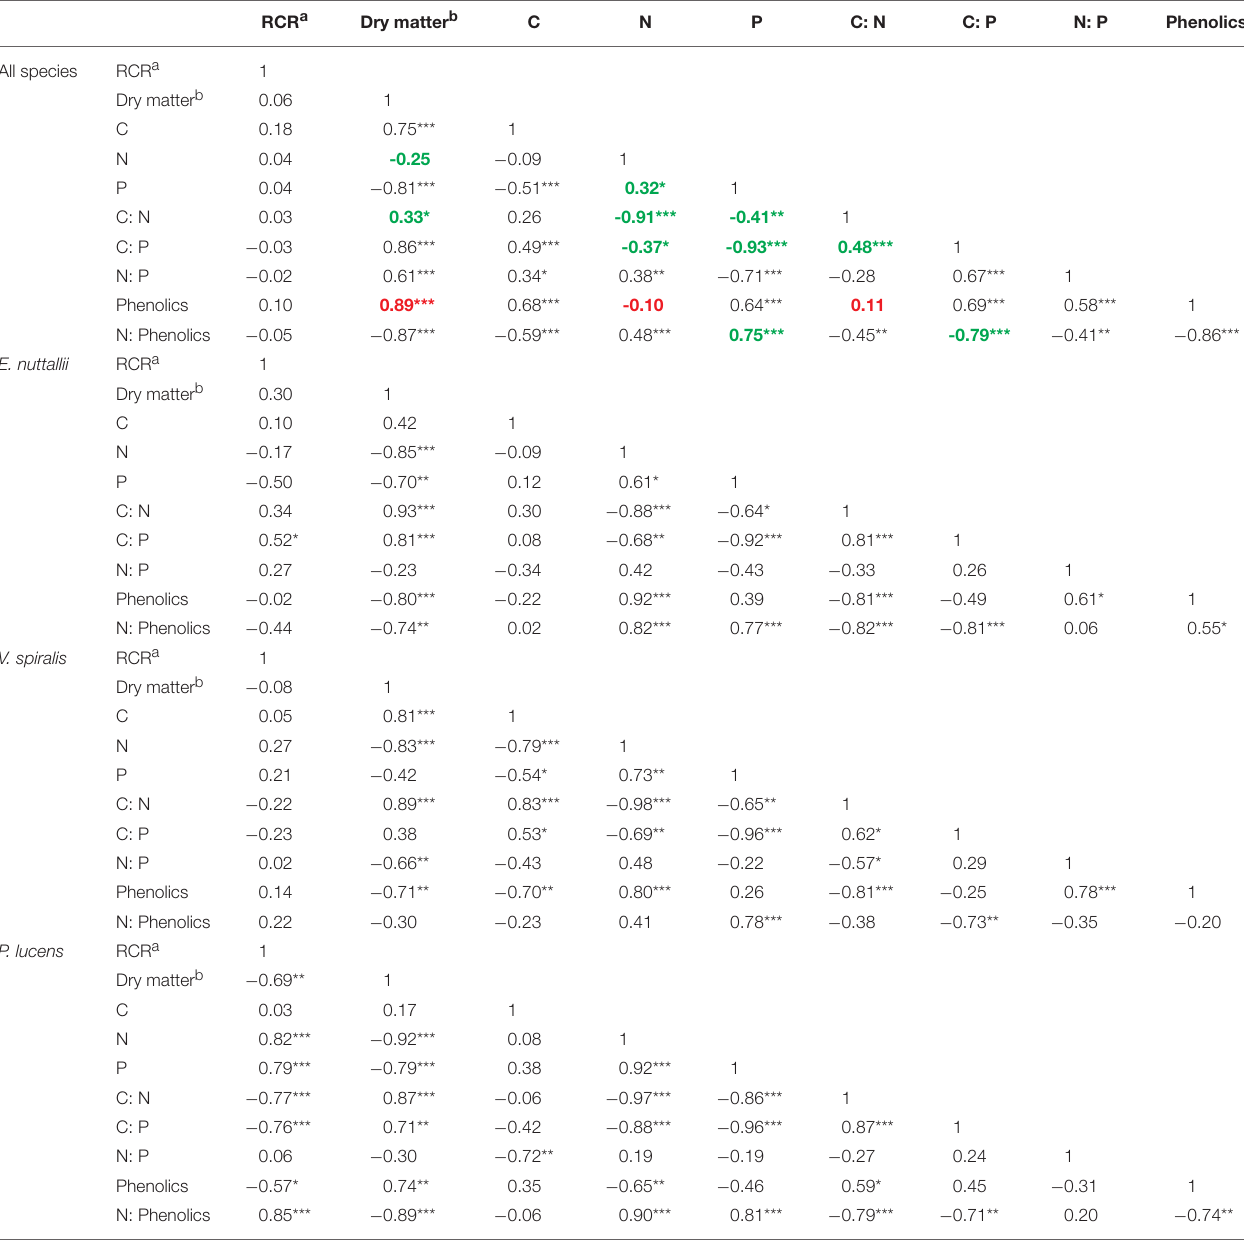
TABLE 2 | Pearson’s correlation coefficients among all the investigated plant quality traits for all three species pooled ( n = 45), and for each species separately ( n =